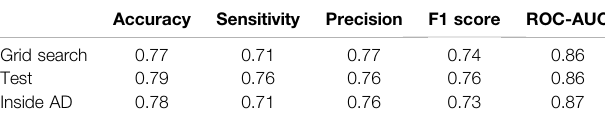
TABLE 3 | Performance of the predictive model for the anti-HSV-1 activity.